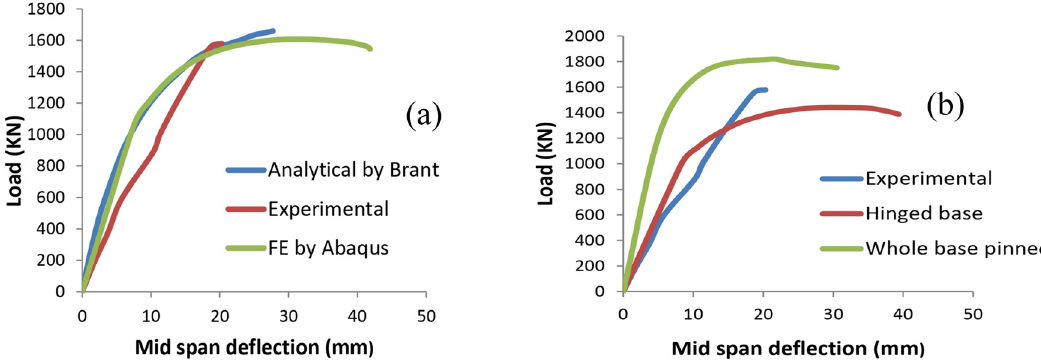
Figure 4: ( a ) Load – mid - span de fl ection and ( b ) load – de fl ection for di ff erent end